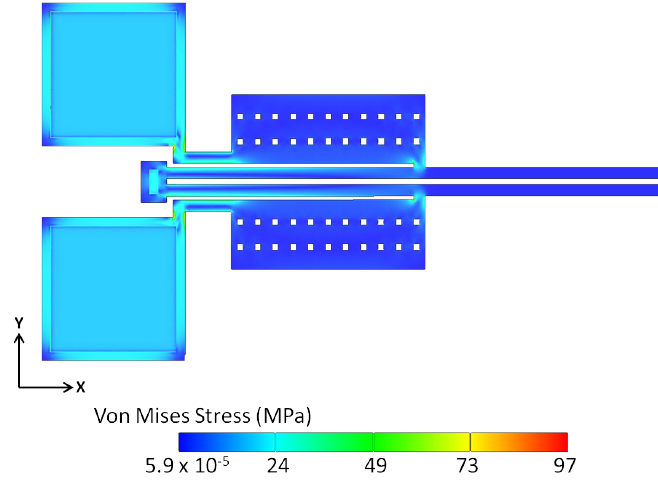
Figure 16. Von Mises stresses developed within the polysilicon microgripper structure at a potential of 3